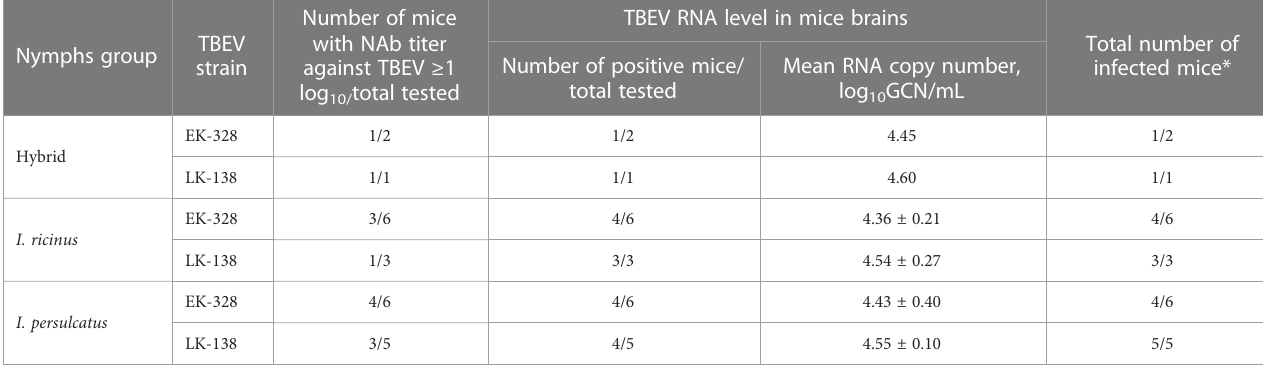
TABLE 2 Effectiveness of the Siberian (strain EK-328) and European (strain LK-138) TBEV subtypes transmission from infected Ixodes ricinus , Ixodes persulcatus , and hybrid questing nymphs (infected as larvae) to laboratory mice.